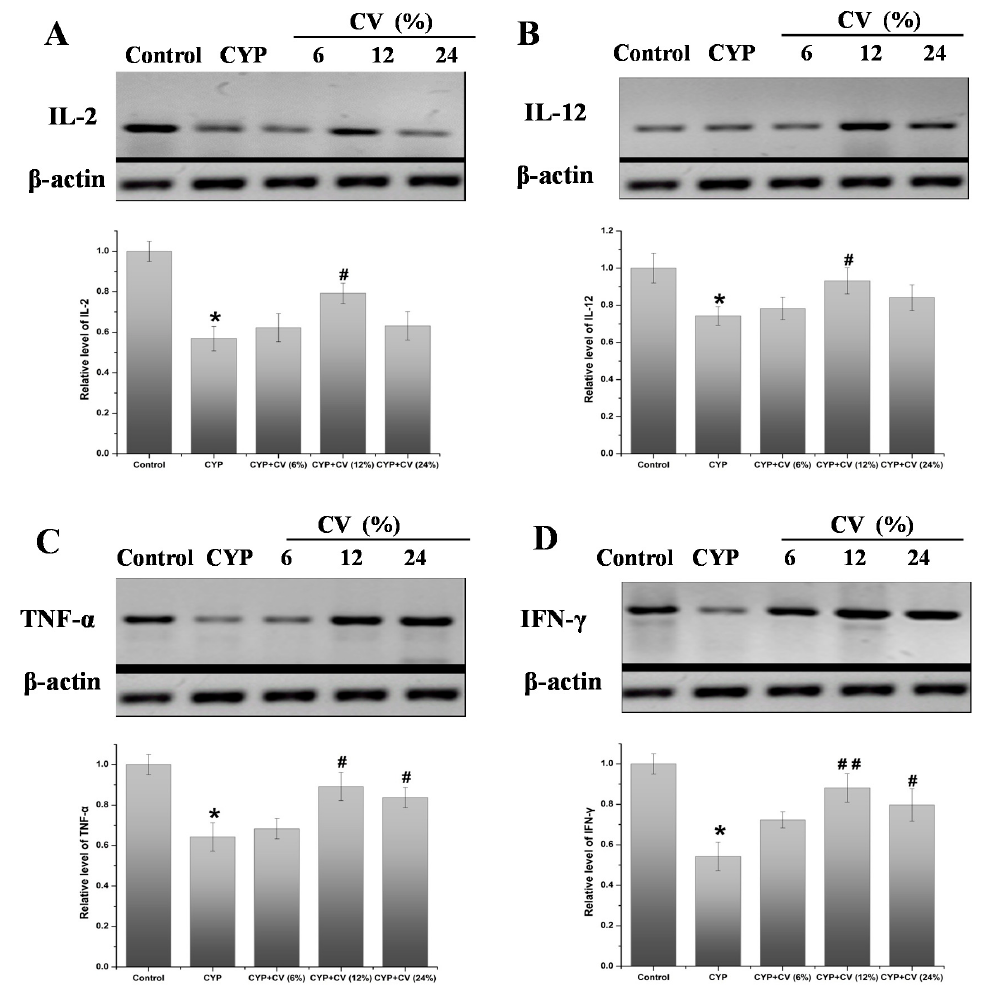
Figure 6. Effects of CV on the level of IL-2 ( A ), IL-12 ( B ), TNF- α ( C ) and IFN- γ ( D ) proteins in the spleen of CYP-treated mice. The β -actin was used as the control. Note: Data were expressed as mean ± SD, *: only the CYP treatment was compared against the control treatment ( p < 0.05); #: only the CYP + CV treatment was compared against the CYP treatment ( p < 0.05), ##: only the CYP + CV treatment was compared against the CYP treatment ( p < 0.01).